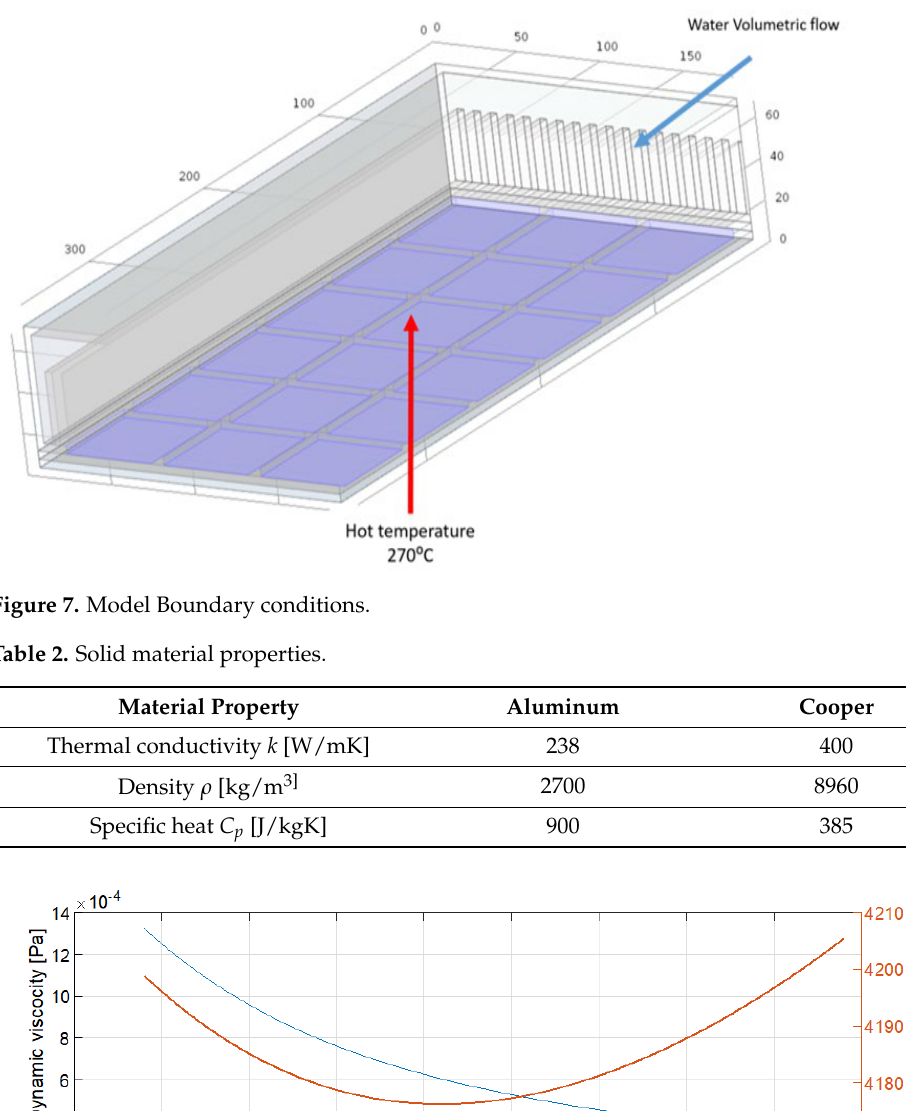
Table 2. Solid material properties.